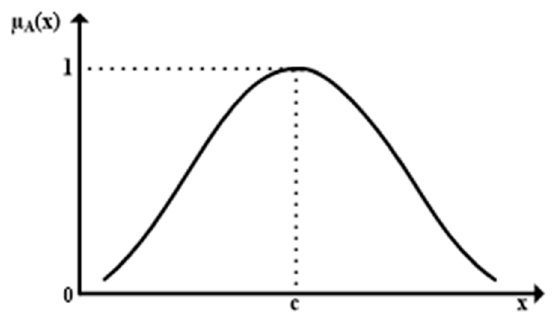
Figure 5. The curve of Normal Distribution Membership Function.